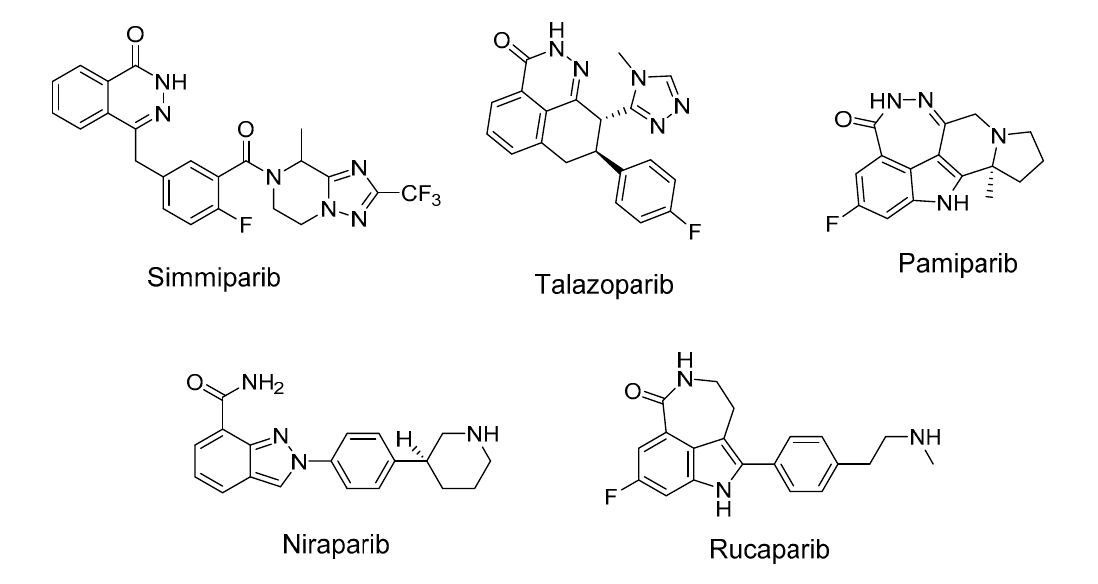
Figure 2. Some known inhibitors of PARP1.